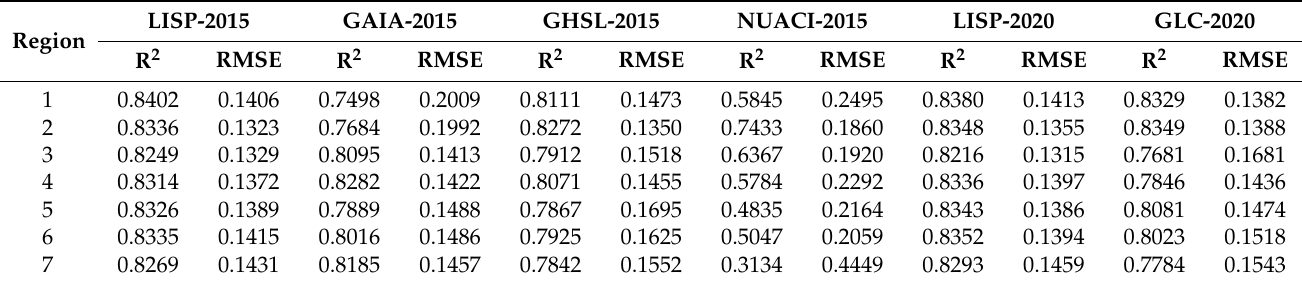
Table 6. Accuracy of the five impervious surface